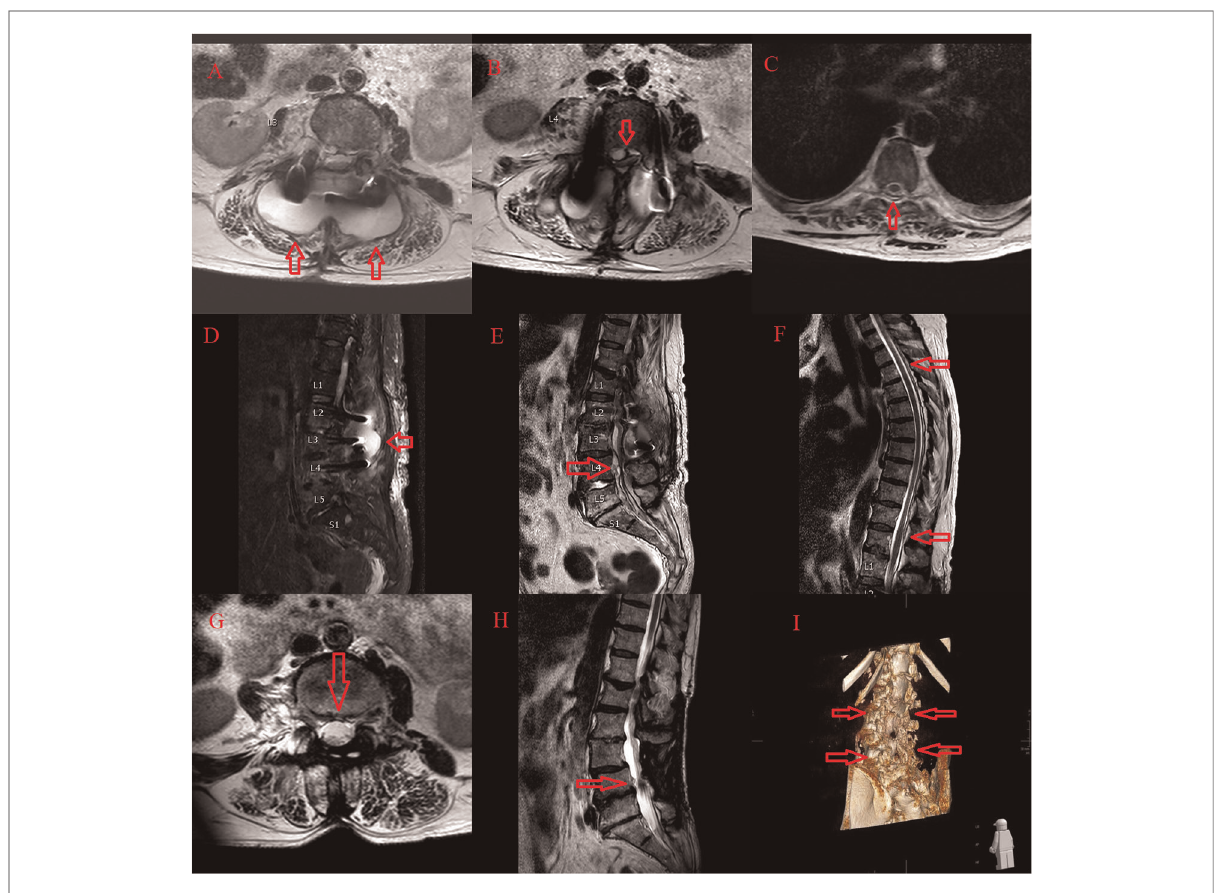
FIGURE 3 Emergent MRI demonstrated pyogenic spondylodiscitis with paraspinal and epidural purulent collection at the level of spondylodesis L2 to L4 ( A,D ) with total spinal stenosis at the L4 level ( B,E ). Concomitant purulent collections, without neurologic compromise, from the Th4 to Th12 level ( C,F ). The follow-up imaging revealed residual fl uid collections in the paraspinal soft tissue and right psoas muscle, with regression of spondylodiscitis, resolution of total spinal stenosis at the L4 level ( G,H ), and evidence of bone fusion with postoperative deformity at the level of surgery ( I